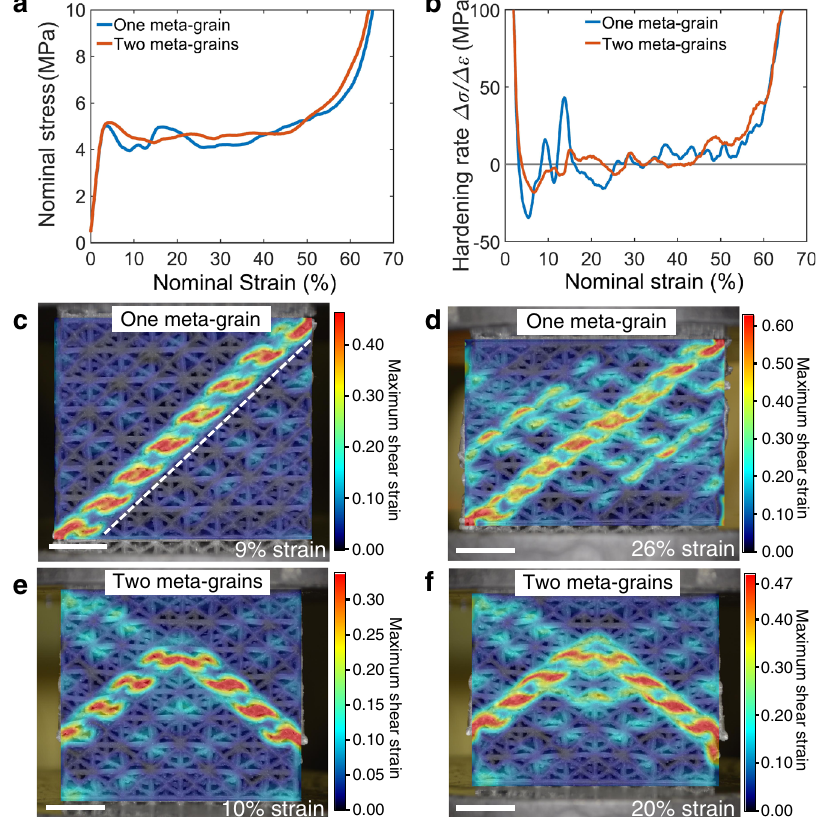
Fig. 3 Comparison between single and bi-meta-crystals. a Stress – strain curves. b Hardening rate. c – f Deformation behaviours of each lattice at given strains after DIC analyses. The length-scale bar in ( c – f ) is